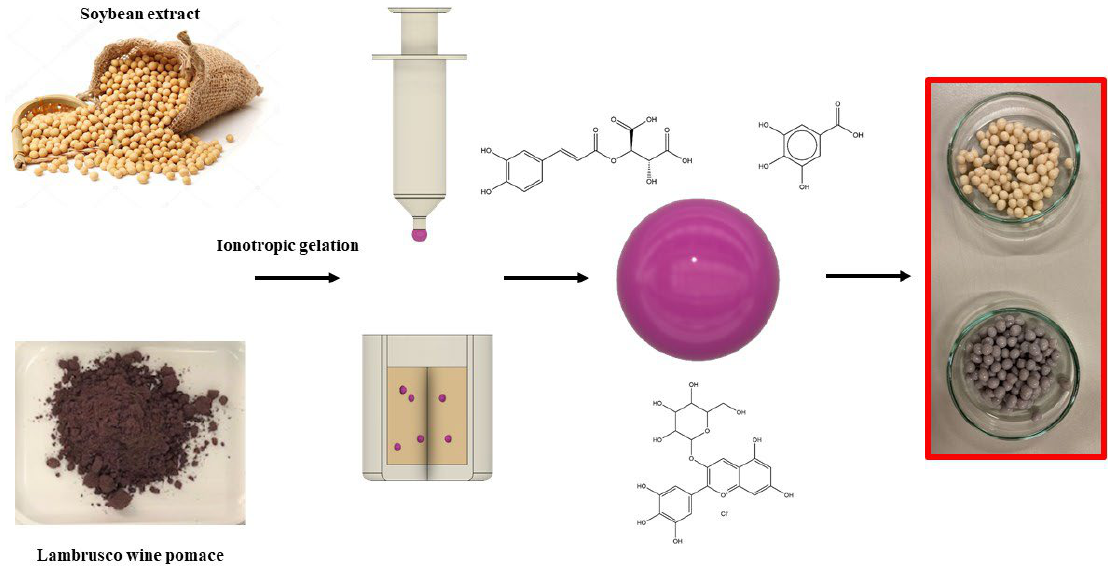
Figure 10. Schematization of ionotropic gelation and production of soybean extract-based beads.